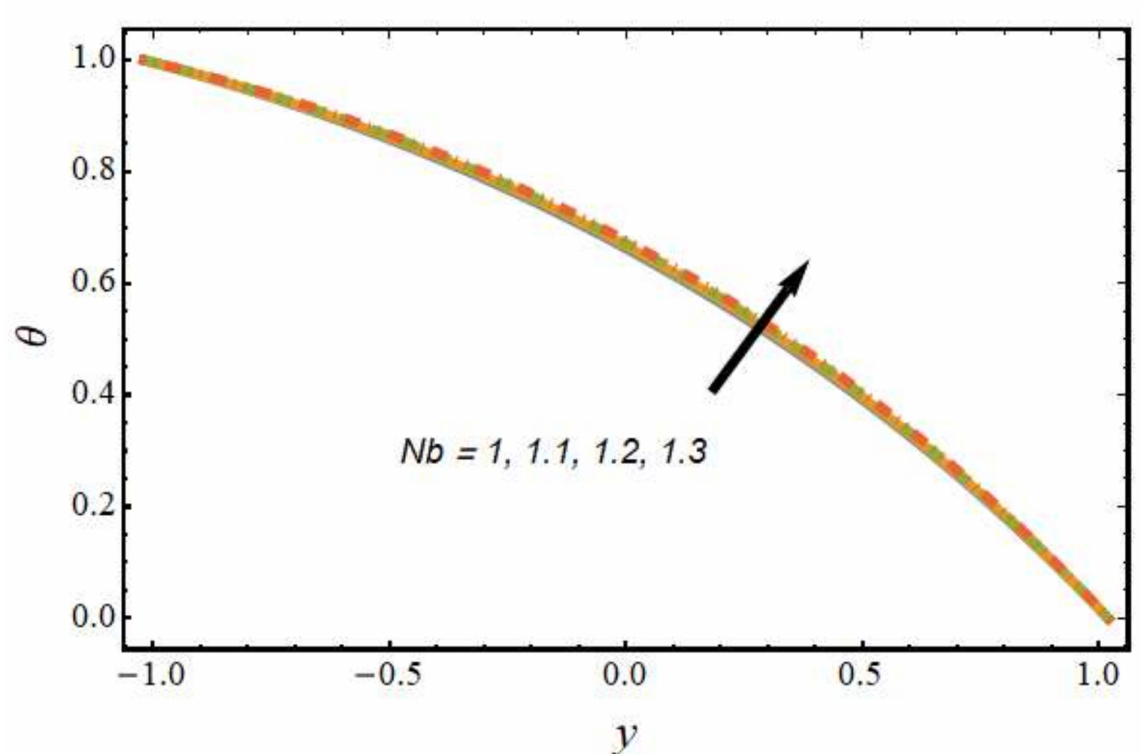
Figure 10. Nanoparticle temperature profile for various values of the Brownian motion parameter.